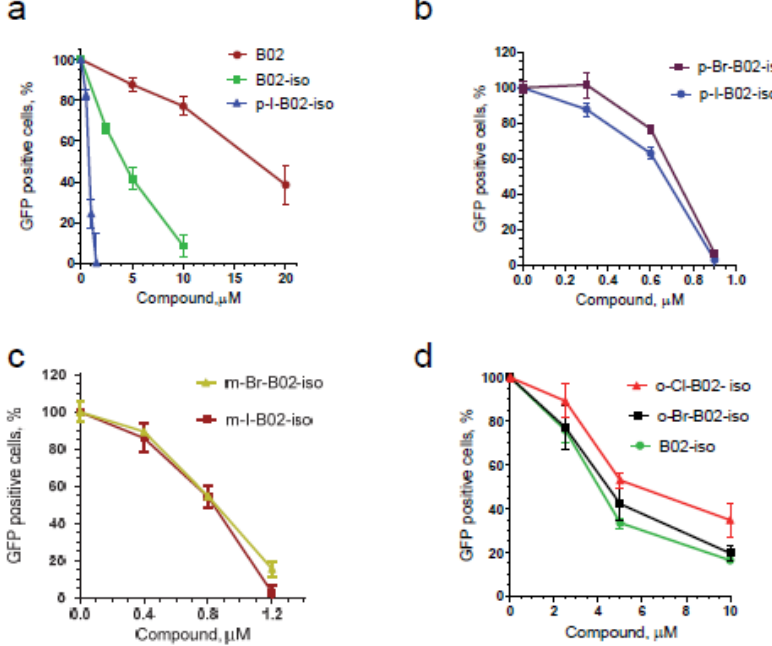
Figure 3. B02-iso and its halogen derivatives efficiently inhibit HR in human U-2 OS cells. The efficiency of HR was measured using IndDR-GFP assay. The effect of the following compounds was examined: ( a ) B02, B02-isomer and p-I-B02-iso; ( b ) p-Br-B02-iso and p-I-B02-iso; ( c ) m-Br-B02-iso and m-I-B02-iso; ( d ) o-Cl-B02-iso, o-Br-B02-iso and B02-iso. The experiments were repeated at least three times. The error bars represent the standard error of the mean (SEM).